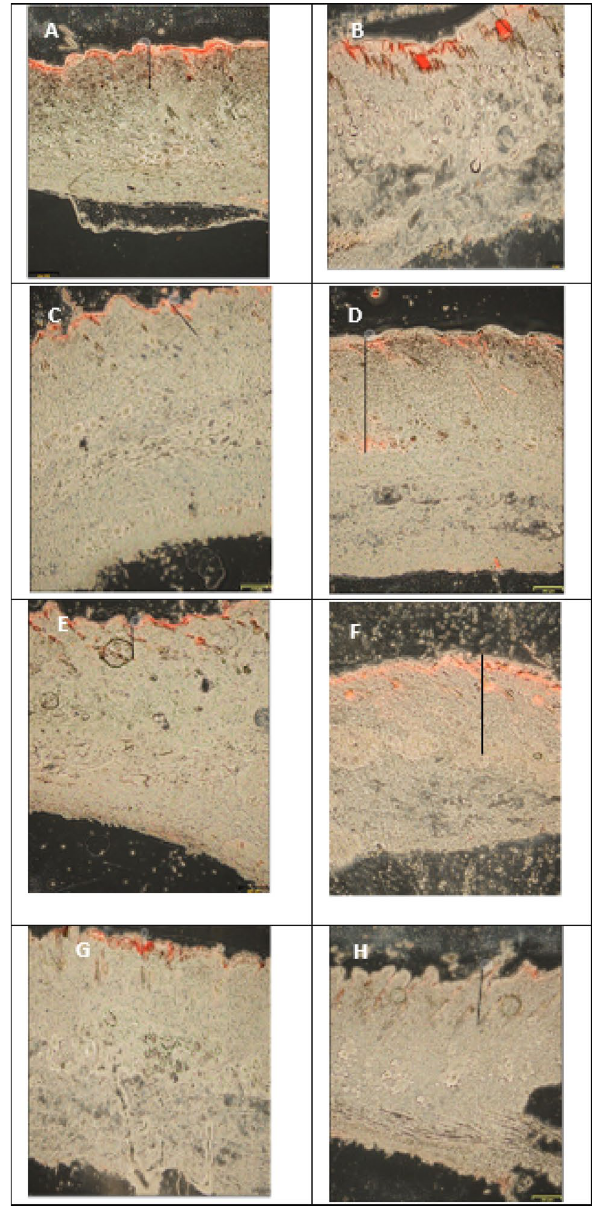
Figure 3. Penetration and distribution of nile red in rat skin of PMCA cream, observed after 2 h ( A ) and 4.5 h ( B ), PMCA_SLN observed after 2 h ( C ) and 4.5 h ( D ), NLC base observed after 2 h ( E ) and 4.5 h ( F ), PMCA_ NLC observed after 2 h ( G ) and 4.5 h ( H